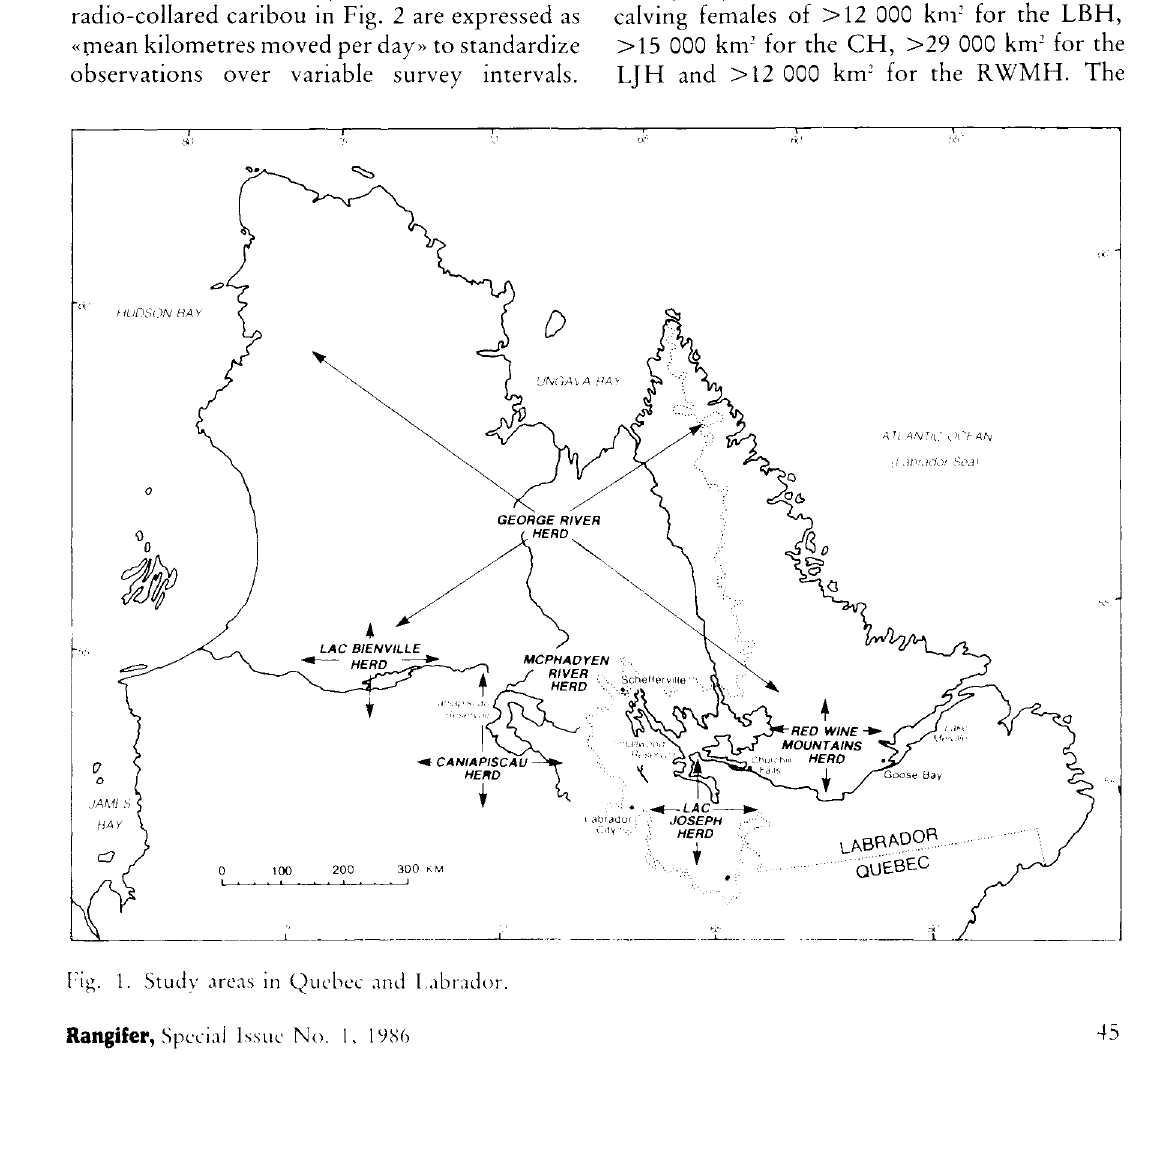
Fig. 1. Study areas in Quebec and